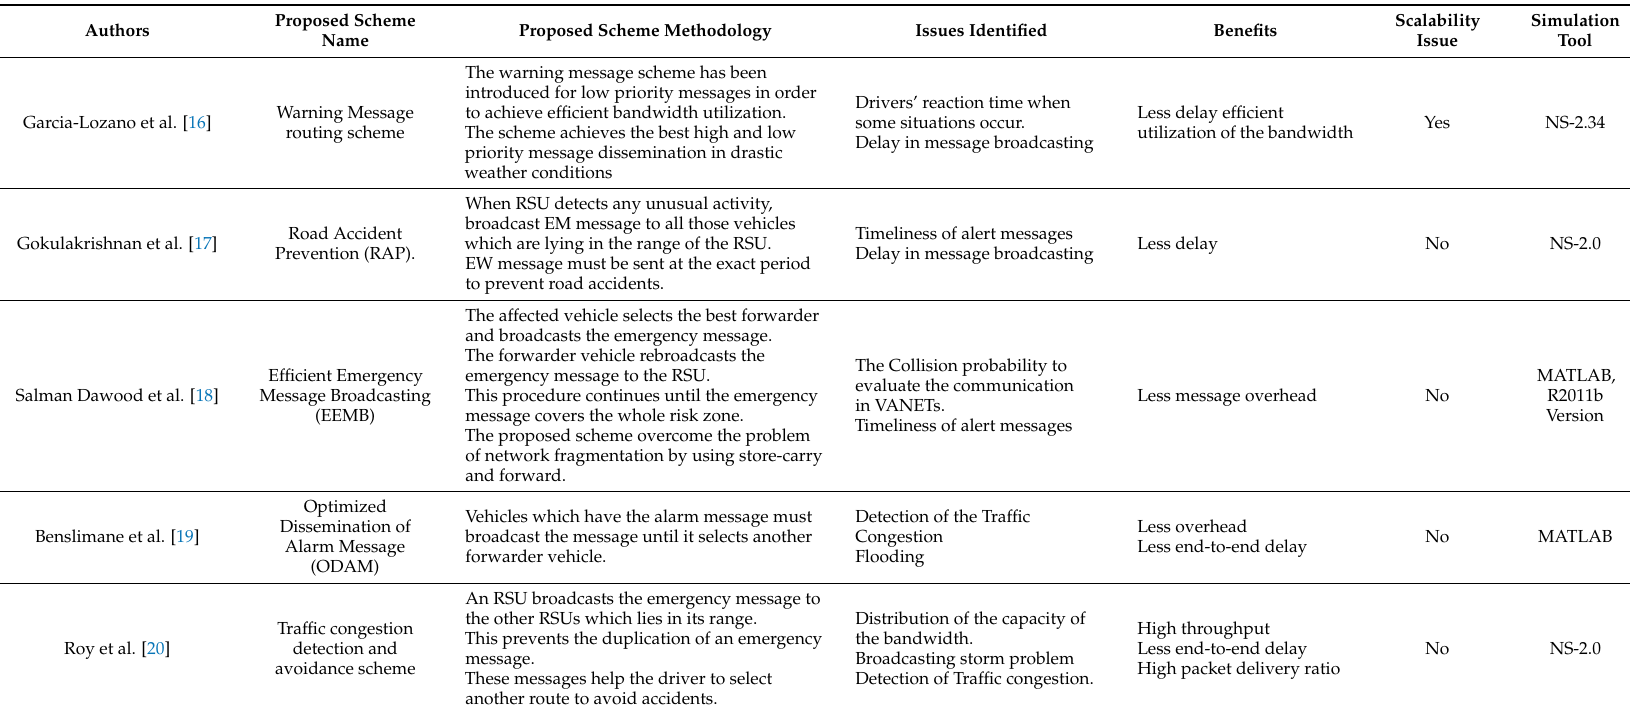
Table 1. Literature review of traffic accident prevention and avoidance schemes based on Safety/Warning